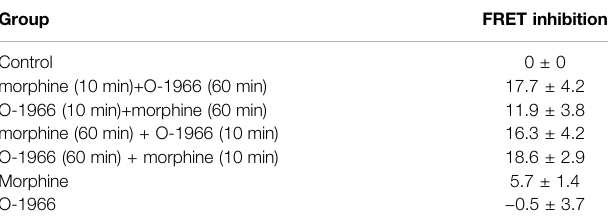
TABLE 3 | FRET Analysis of morphine and O-1966 co-treated cells.